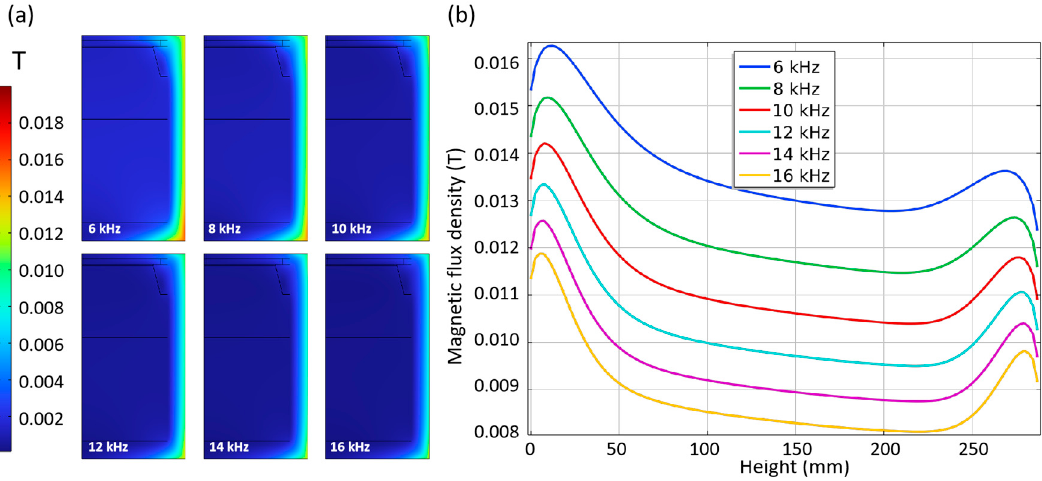
Figure 6. ( a ) Magnetic flux density (MFD) of Crucible; ( b ) MFD along the outer wall of